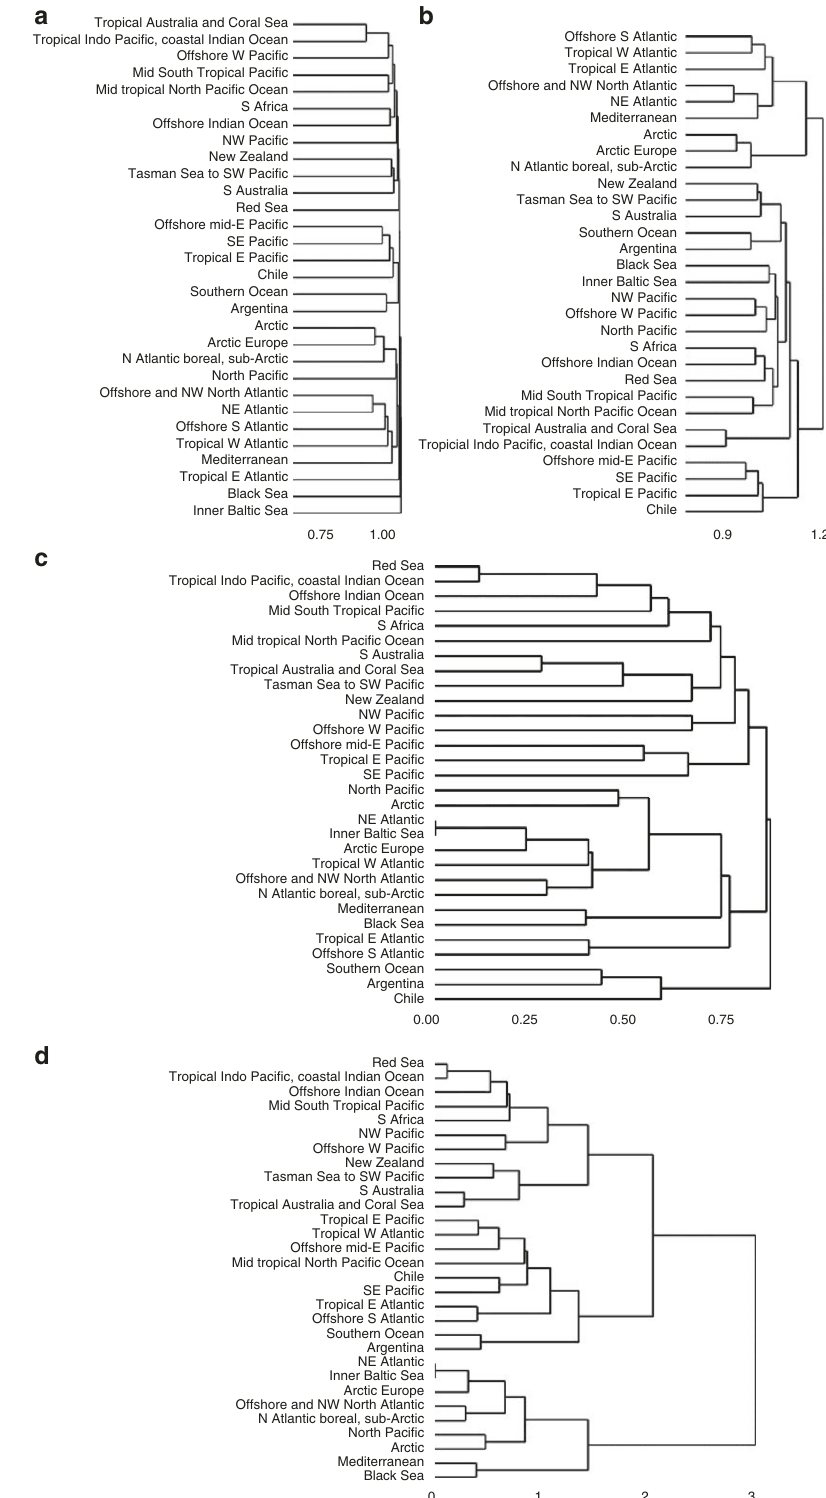
Fig. 1 Examples of analysis of hierarchical relationships between the realms using Jaccard ’ s similarity coef fi cient with a Group Average and b Ward ’ s clustering methods; and Simpson ’ s similarity coef fi cient clustered using c Group Average and d Ward ’ s clustering